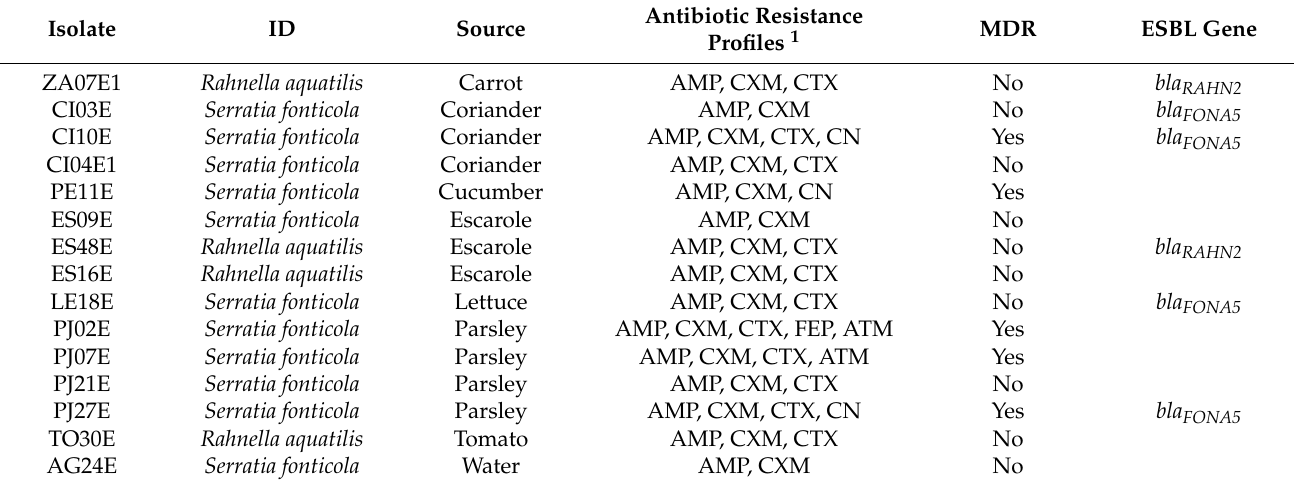
Table 2. ESBL-producing Enterobacteriaceae isolated from vegetables and farm environment samples.